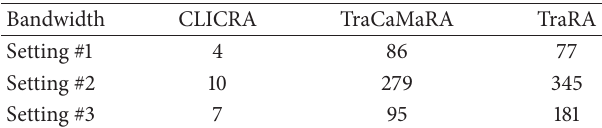
Table 3: Buffer underflow count.